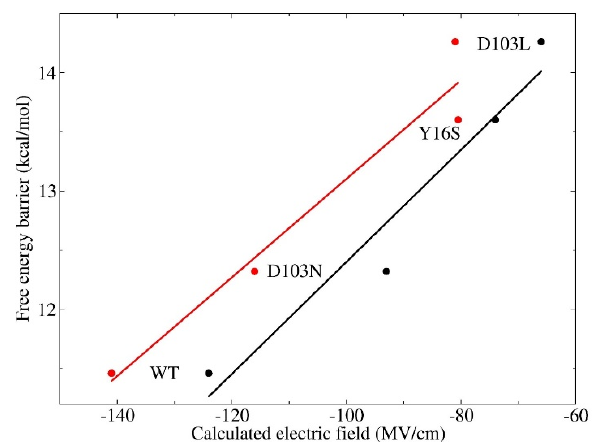
Figure 5. Correlation between the calculated electric fields and the free energy barriers for wild-type and variants of KSI. The experimental values (the activation energies of wild-type KSI and its variants) were obtained from Fried et al. [5], which were estimated from the experimental catalytic rate constant of k cat by ∆ G = − RT ln [ k cat / ( k B T / h )] , where T = 293 K, R is the ideal gas constant, k B is the Boltzmann constant, and h is the Planck constant. The best-fit lines are marked in red and black for calculations by EE-GMFCC ( R 2 = 0.95) and the Amber ff99SB force field ( R 2 = 0.94),